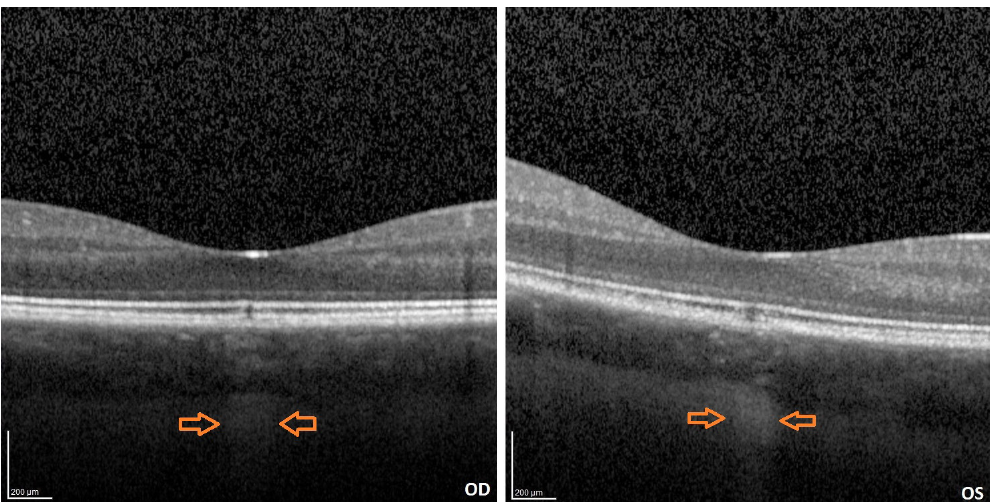
Figure 2: SD-OCT image of both eyes: orange arrows point to streaks of increased reflectivity at the sclera and above it in the choroid.